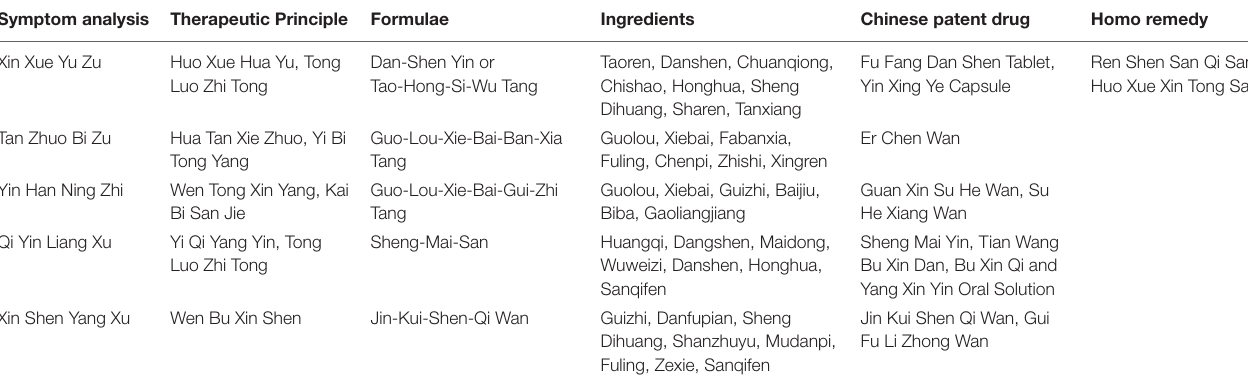
TABLE 3 | Formulae for coronary heart disease and angina pectoris based on syndrome